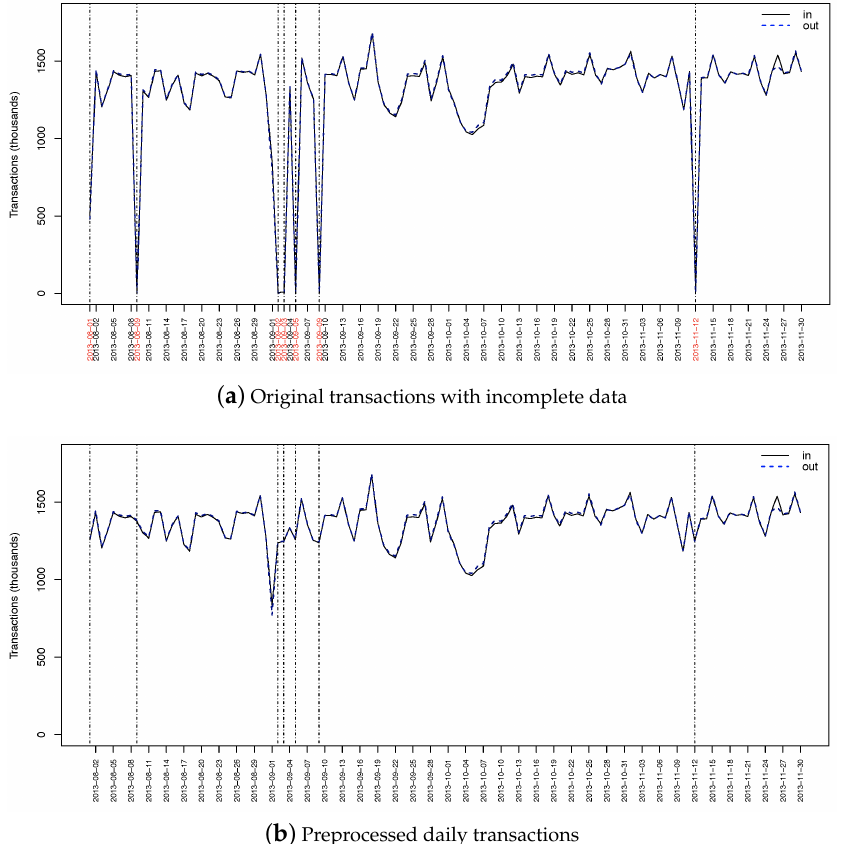
Figure 1. Aggregated daily transactions in Shenzhen metro smart card data of all transactions over 4-month period, where the black line represents in-station volume, and the dashed blue line denotes out-station